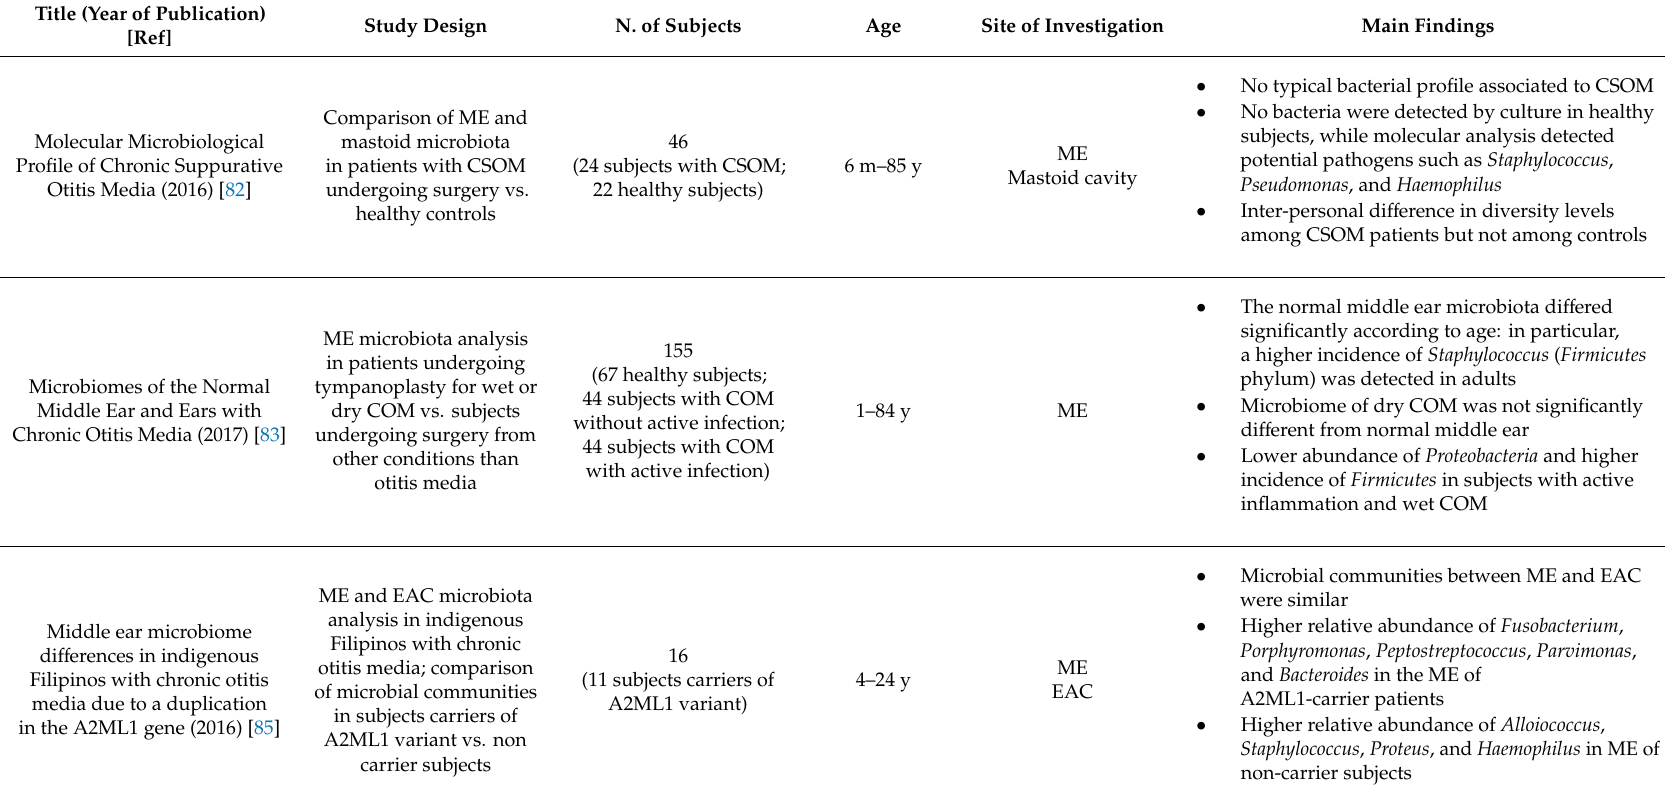
Table 4. Overview of investigations on microbiota and chronic suppurative otitis media discussed in this